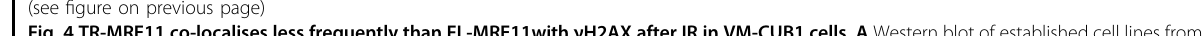
(Fig. S1A – C). TR-MRE11 also increased in a cell density- dependent manner (Fig. S1D, E). In order to elucidate the mechanism, we fi rst focused on the seven aspartic acids